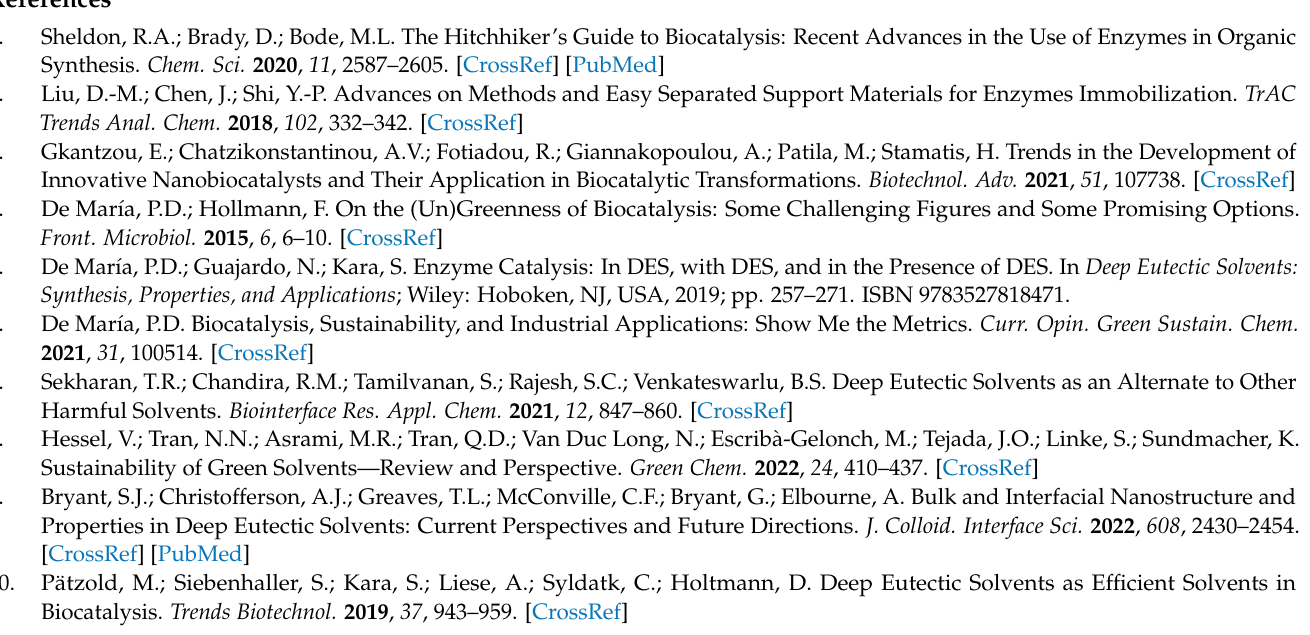
Figure S4: Photographic evidence of the gelation that occurs in the chitosan solution that contains tyrosinase mCLEAs, chitosan and caffeic acid, due to the oxidative action of the biocatalyst (right). The solutions of chitosan and caffeic acid (left) and chitosan and tyrosinase mCLEAs (middle) do not show the gelation phenomenon; Figure S5: Photographic evidence of the color change (browning) of chitosan during the oxidation-grafting reaction of caffeic acid via the action of tyrosinase mCLEAs. The solution of chitosan and caffeic acid remains yellowish in the course of time; Figure S6: ATR spectra of the neat chitosan film (CS film), the chitosan film containing 10% v / v DES (DES-CS film), the mCLEAs-modified chitosan film with caffeic acid containing 10% v / v DES (CA-DES-CS film); the spectrum of DES Bet:Gly (1:3) is shown for comparison. In the DES’s spectrum, the bands observed at 930–1110 cm − 1 are attributed to glycerol, whereas the bands in the 1331–1624 cm − 1 can be assigned to betaine